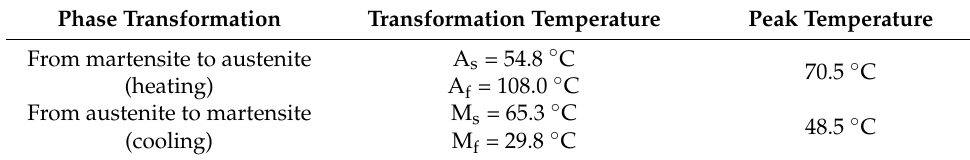
Figure 8. DSC test on the SMA specimen. Table 2. Transformation temperature of the SMA specimen.